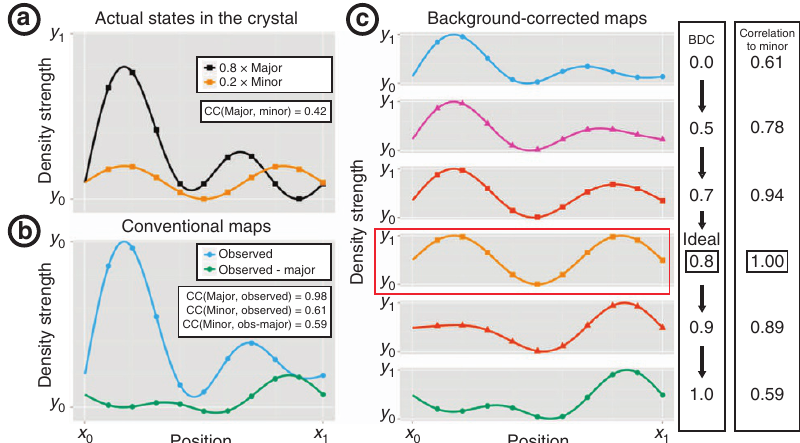
Figure 2 | Minor conformations are obscured in conventional maps but are revealed by background correction. 1D simulations are used to illustrate 3D electron density. ( a ) The actual crystal contains 80% major (black) and 20% minor (orange) states, which are largely dissimilar (correlation: 0.42). ( b ) Conventional (2mF o –DF c ) maps (blue) show only the superposition, which resembles the major far more than the interesting minor state (correlations: 0.98 and 0.59; in practice, the scale is arbitrary). Isomorphous difference (F o –F o ) maps (green) show the subtraction of the full-occupancy major state from the observed data set, and do not resemble the minor state either, except where the major state has low density (right side). ( c ) ‘Event maps’ (scaled for comparison), generated as in equation (1) for different values of BDC, reveal the minor state optimally for only one value of BDC (0.8, indicated in red). BDC ¼ 0.0 corresponds to the observed density, and BDC ¼ 1.0 to a F o –F o map.